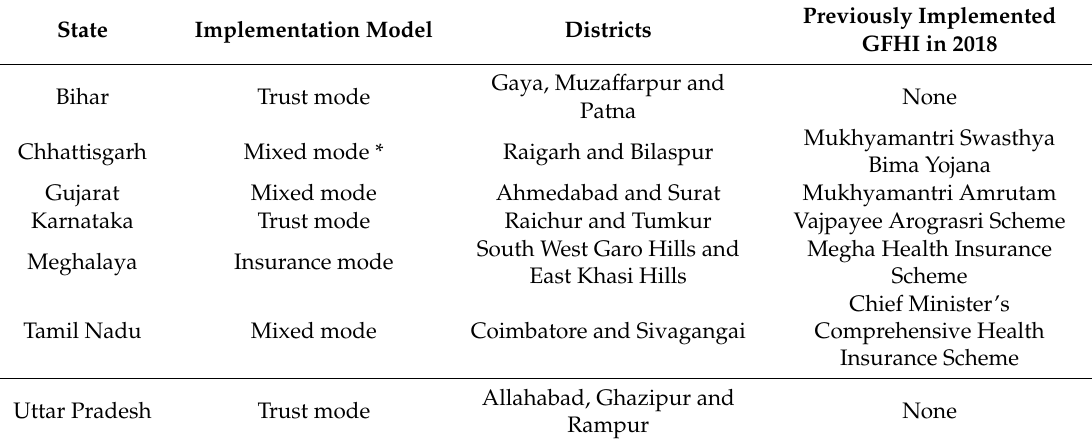
Table 1. Study states, implementation modes, and districts.